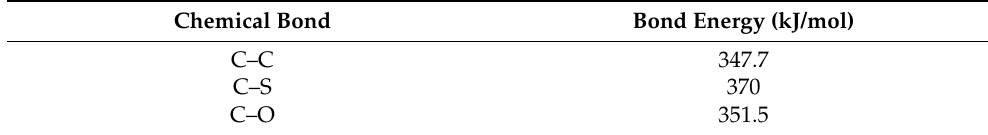
Table 3. The binding energy of some chemical bonds in the PEDOT:PSS